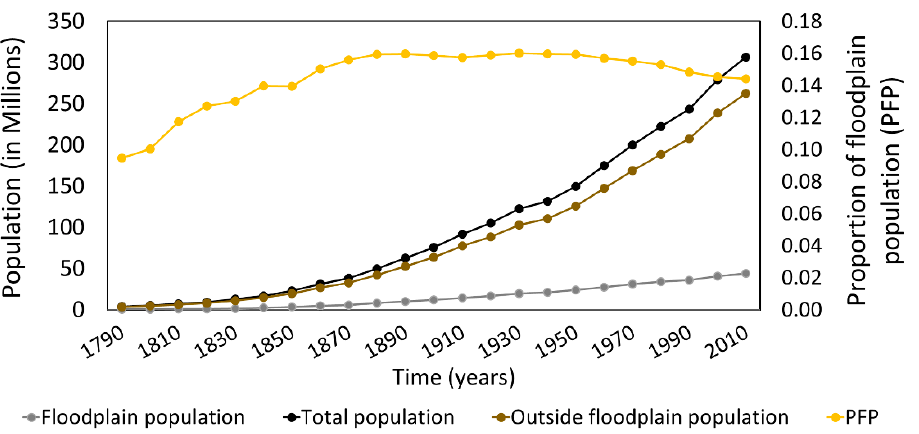
Figure 4. Temporal change in population and floodplain to the total population ratio in the contiguous US from 1790 to 2010.